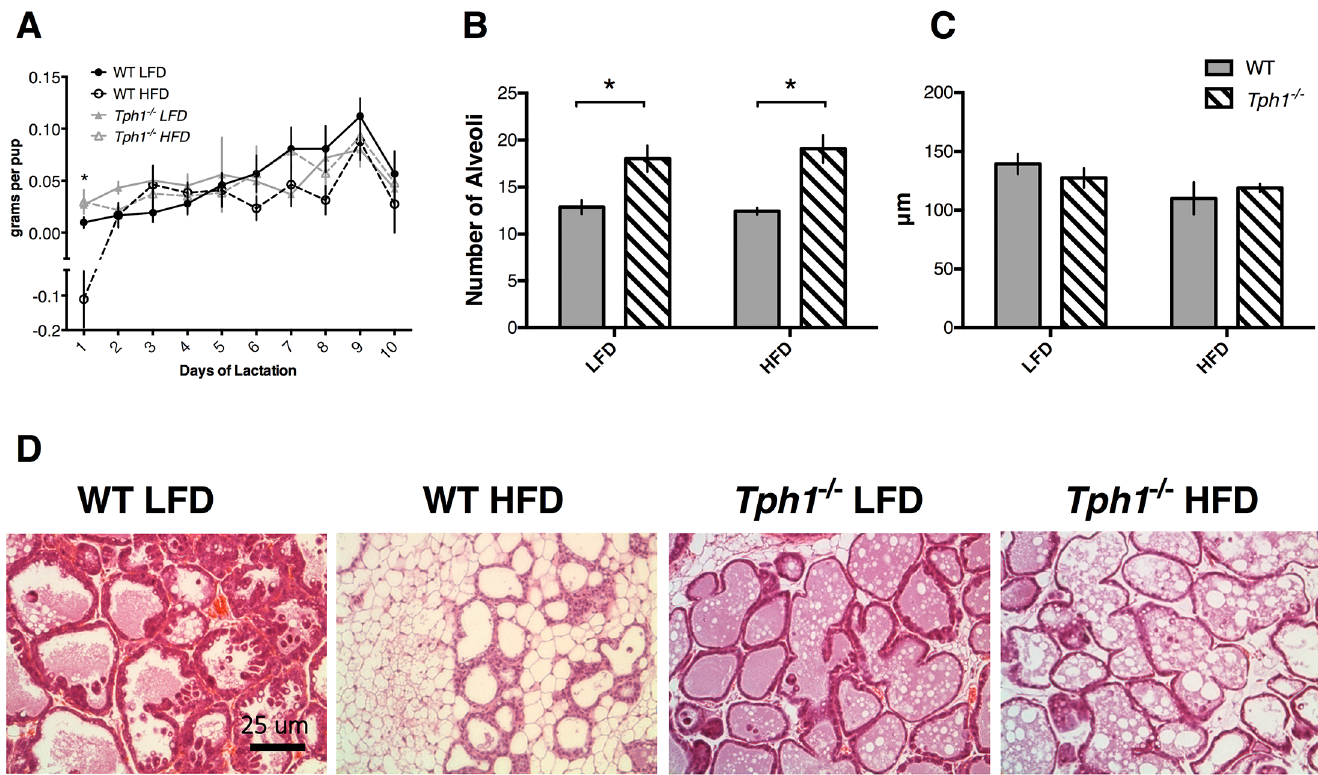
Fig 3. Milk yield and mammary gland morphology are altered in response to high fat or low fat diet in wild type and Tph1 deficient dams. Wild type or Tph1 deficient dams were either fed a high fat or low fat diet throughout pregnancy and lactation. Shown are the effects on ( A ) milk yield (grams per pup), ( B ) number of alveoli in the mammary gland, ( C ) size of alveoli in the mammary gland ( μ m), ( D ) mammary gland morphology as visualized by hematoxylin and eosin staining. Values are means ± SEMs. Stars indicate statistical significance between groups ( * = 0.05 < P < 0.01, ** = 0.01 < P < 0.001, *** = 0.001 < P < 0.0001, **** = P < 0.0001). WT, wild type; Tph1 -/- , Tph1 deficient; LFD, low fat diet; HFD, high fat